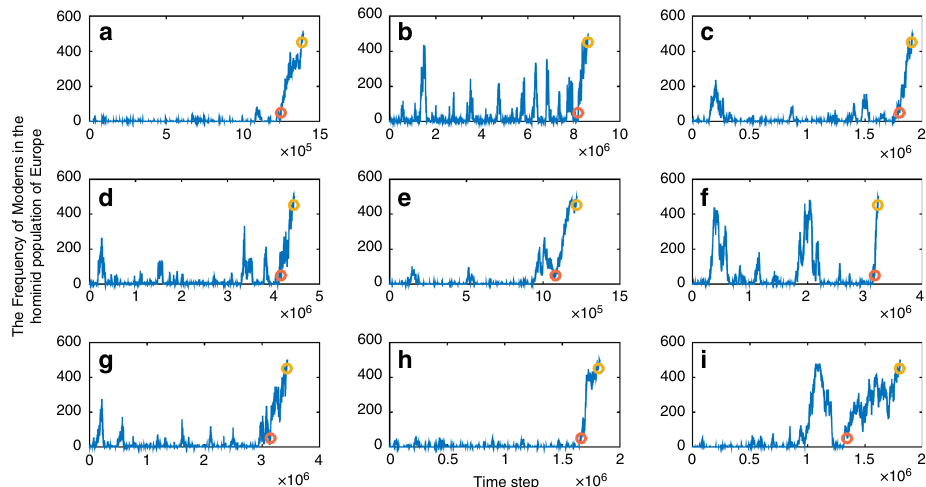
M = 0). Orange and dark 2 , of 0.1 per time step (migration is unidirectional; 1